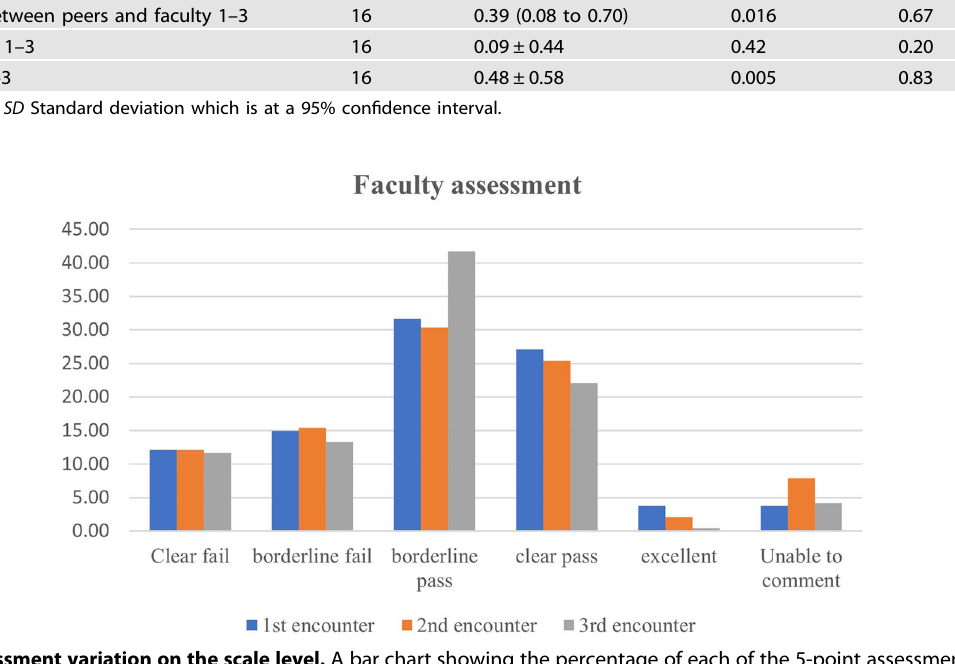
Table 2. Paired t -test comparing mean difference between peers and faculty in the fi rst encounter and the last (3rd) encounter. Pairs n .